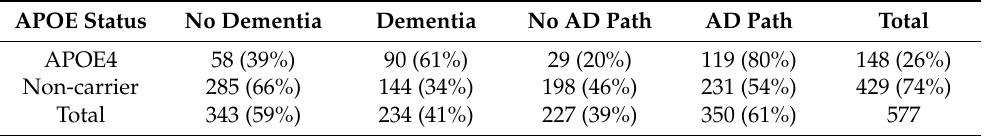
Table 6. APOE4 status of those with clinical dementia or an AD pathology diagnosis in the ROSMAP RNA sequencing